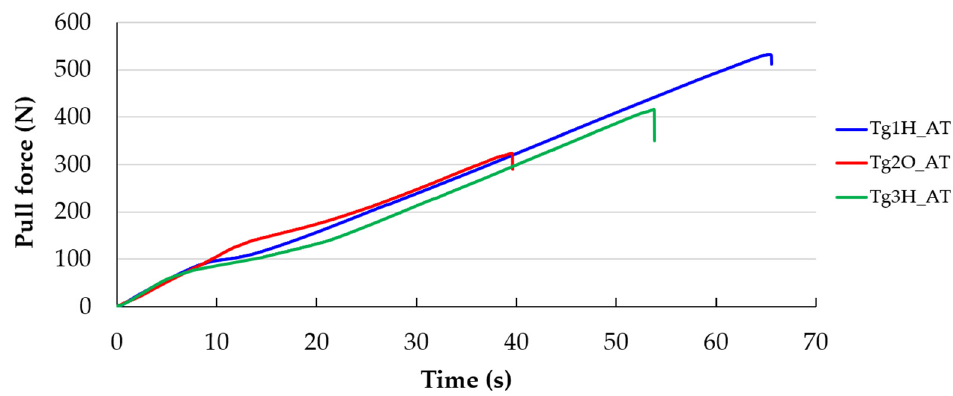
Figure 7. Dependency of pull force on the time.